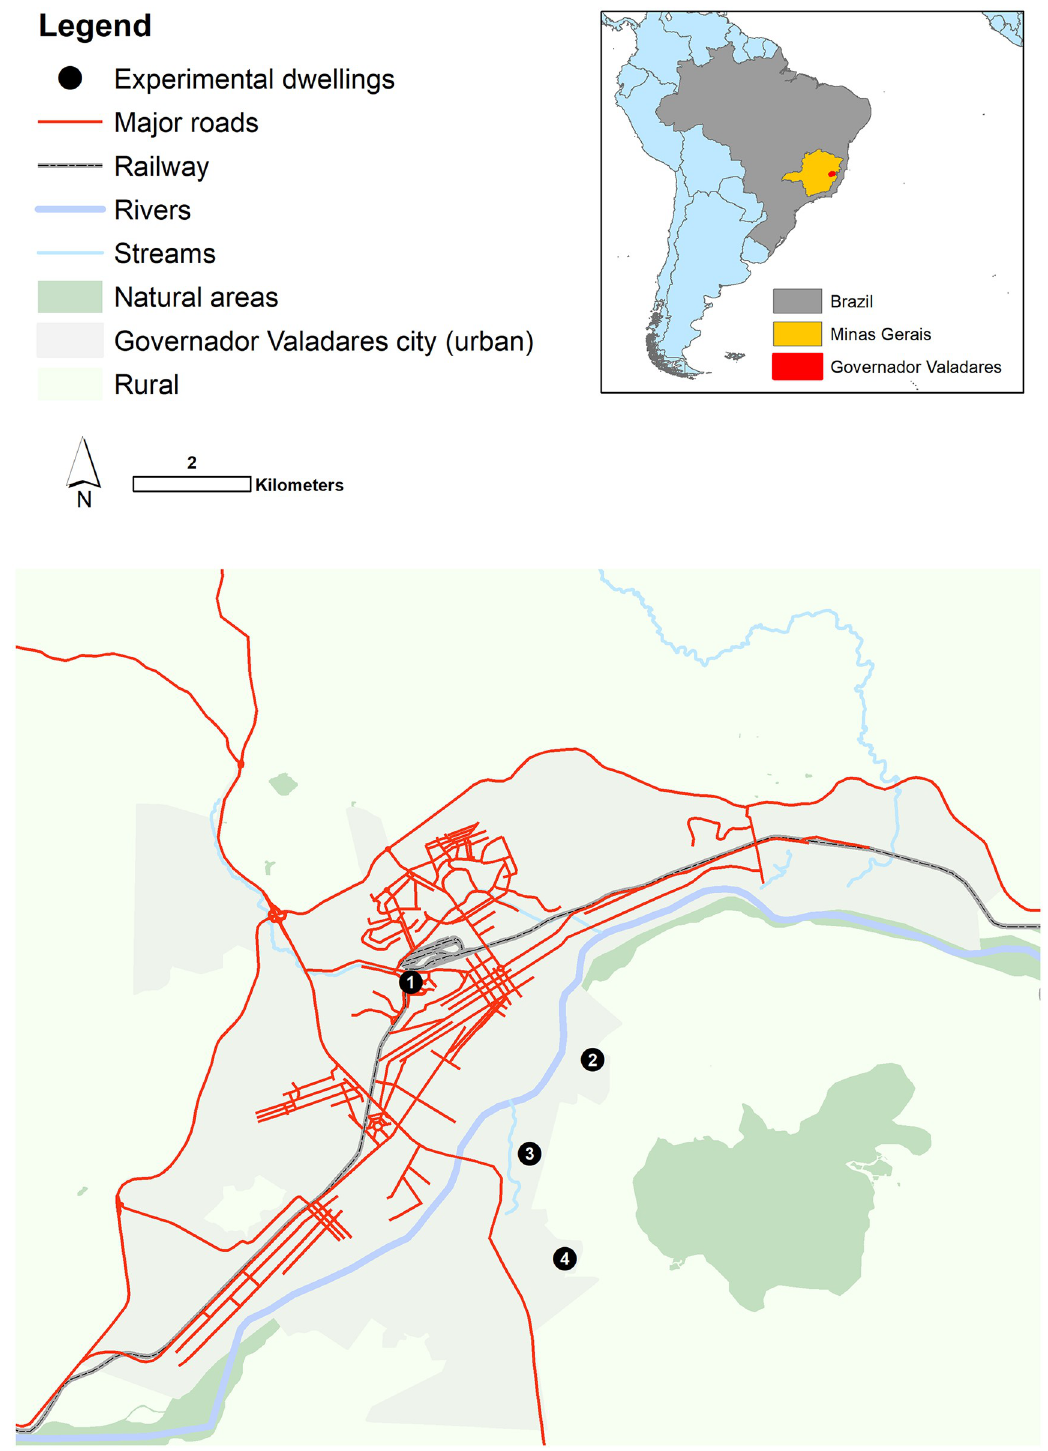
Fig 1. Location of the study site in Governador Valadares, Minas Gerais, Brazil. The four study houses , in separate neighbourhoods are indicated by the black solid circles; 1—Vila Mariana; 2—Village da Serra; 3—Vila Parque Ibituruna; 4— Chacaras Recanto da Cachoeira . [Map produced in ArcGIS 10.4.1, Base layers main map: OpenStreetMap (https://www. openstreetmap.org/search?query=Governador%20Valadares#map=13/-18.8593/-41.9381); Base layers inset map: ESRI World Countries Layer (https://www.arcgis.com/home/item.html?id=ac80670eb213440ea5899bbf92a04998)].